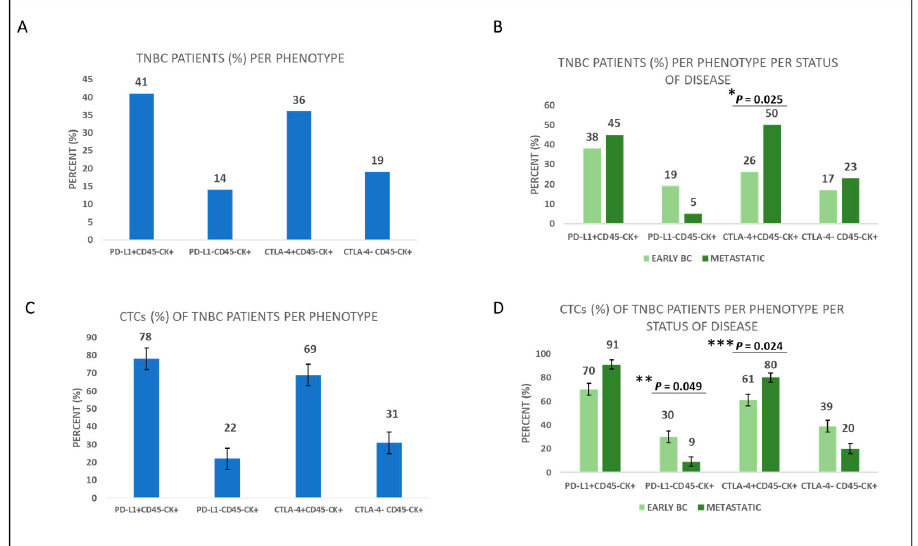
Figure 2. PD-L1 and CTLA-4 expression in TNBC patients’ CTCs. ( A ) Percentage of TNBC patients with all the different phenotypes. ( B ) Percentage of early and metastatic TNBC patients with the corresponding CTC phenotypes (* p = 0.025). ( C ) Percentage of CTCs with all the corresponding phenotypes in TNBC patients. ( D ) Percentage of CTCs with all the corresponding phenotypes in early and metastatic TNBC patients (** p = 0.049, *** p = 0.024). Considering disease status, the percentage of CTCs expressing the phenotype PD- L1 + CD45 − CK + in early vs. metastatic disease was 70% vs. 91%, respectively, whereas the percentage of PD-L1-negative CTCs was 30% vs. 9% ( p = 0.049), respectively. The same percentages for the CTLA-4 + CD45 − CK + phenotype were 61% vs. 80% ( p = 0.024), respec- tively, while for CTLA-4 − CD45 − CK + phenotype they were 39% vs. 20%, respectively (Fig- ure 2D, Table S1). Hence, frequency of the phenotype CTLA-4 + CD45 − CK + was higher in